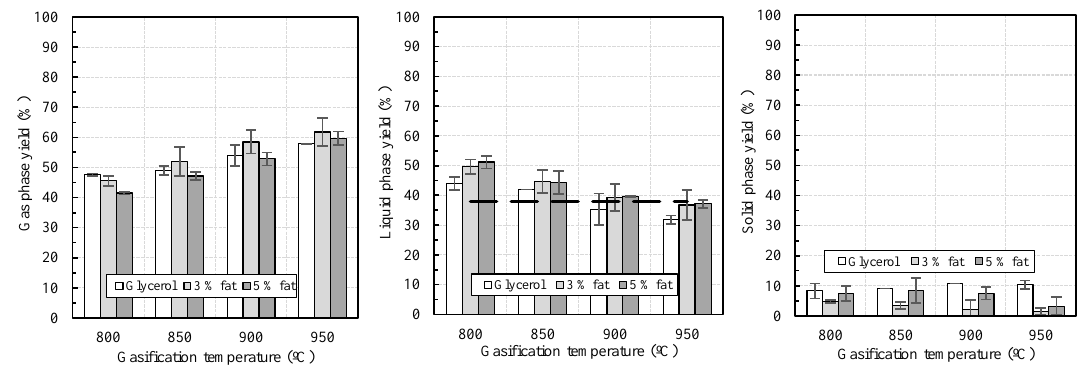
Figure 6. E ff ect of the addition of fat on phase Figure 6. Effect of the addition of fat on phase yields.